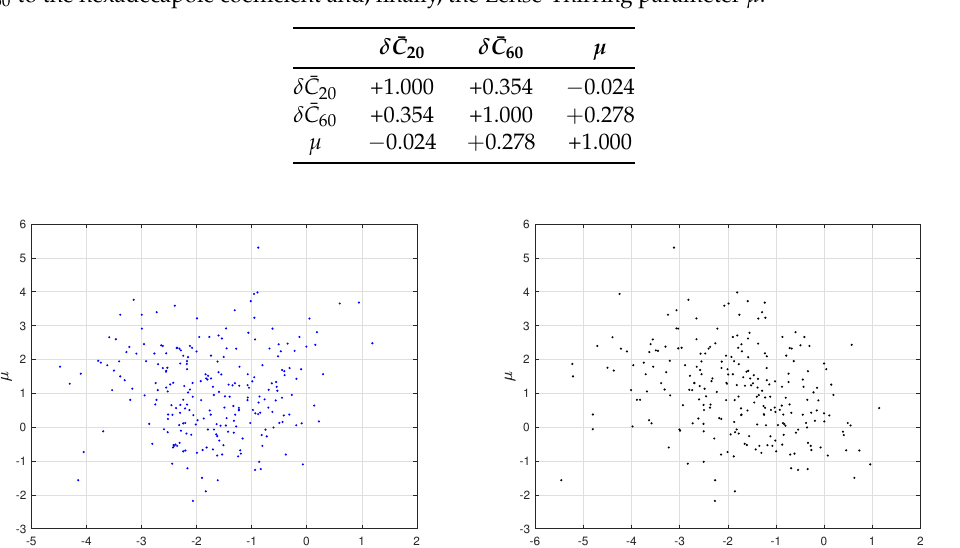
Table 7. Correlations among the three estimated quantities obtained from the solution of a system of three equations in three unknowns: the correction δ ¯ C 20 to the quadrupole coefficient, the correction δ ¯ C 60 to the hexadecapole coefficient and, finally, the Lense-Thirring parameter µ .